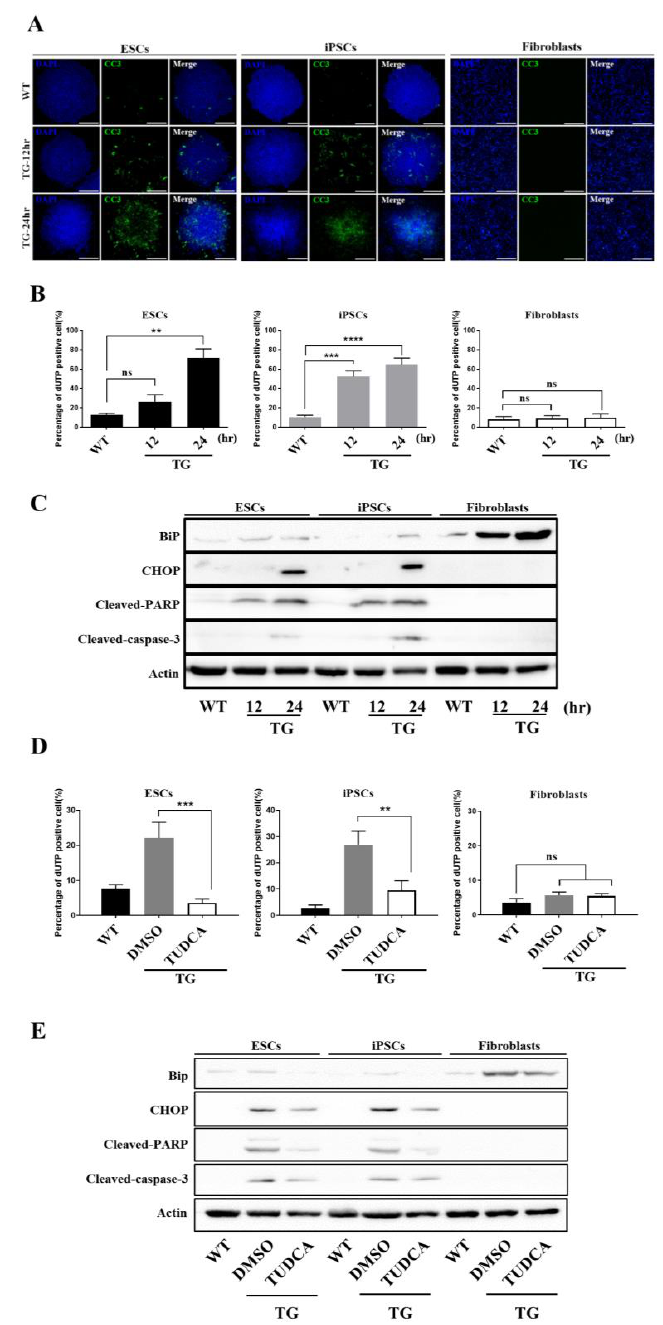
Figure 4. hPSCs are more susceptible to apoptosis. ( A ) Immunostaining data show cleaved caspase-3 expression by GFP fluorescence. GFP was only visible in hPSCs. Scale bar: 300 μm ( B ) Percentage of apoptosis as indicated by bromodeoxyuridine (BrdU) staining using fluorescence-activated cell sorting (FACS). Values represent the mean ± SD. Tukey’s t -test: ** p < 0.01; *** p < 0.001; **** p < 0.00001; “ns” represents non-significant differences. ( C ) Expression levels of BiP, C/EBP homologous protein (CHOP), cleaved-poly (ADP-ribose) polymerase (PARP), cleaved-caspase 3, and actin in hESCs, iPSCs, and fibroblasts treated with TG were assessed by western blotting using specific antibodies ( n = 3). ( D ) Percentage of apoptotic treated and untreated cell lines measured by BrdU staining. Values represent the mean ± SD. Tukey t -test: ** p < 0.01 or ** p < 0.001. ( E ) Expression levels of BiP, CHOP, cleaved-PARP, cleaved-caspase3, and actin in hESCs, iPSCs, and fibroblasts treated with TG for 12 h and then DMSO and tauroursodeoxycholic acid (TUDCA) for 12 h were assessed by Western